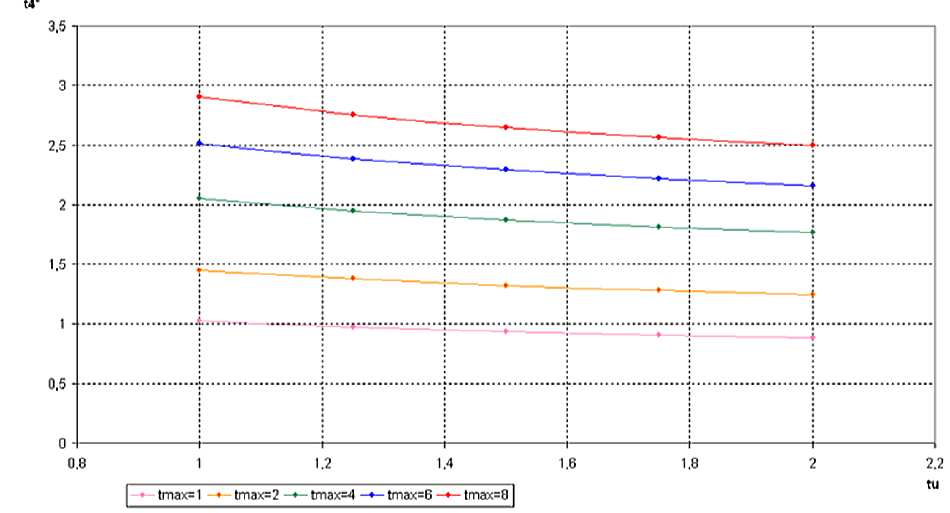
Figure 4. Evolution of *